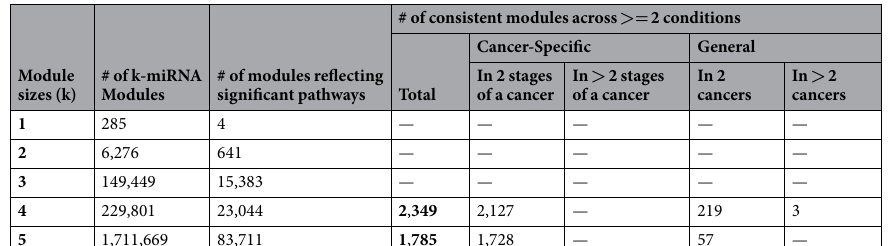
# of k-miRNA Modules